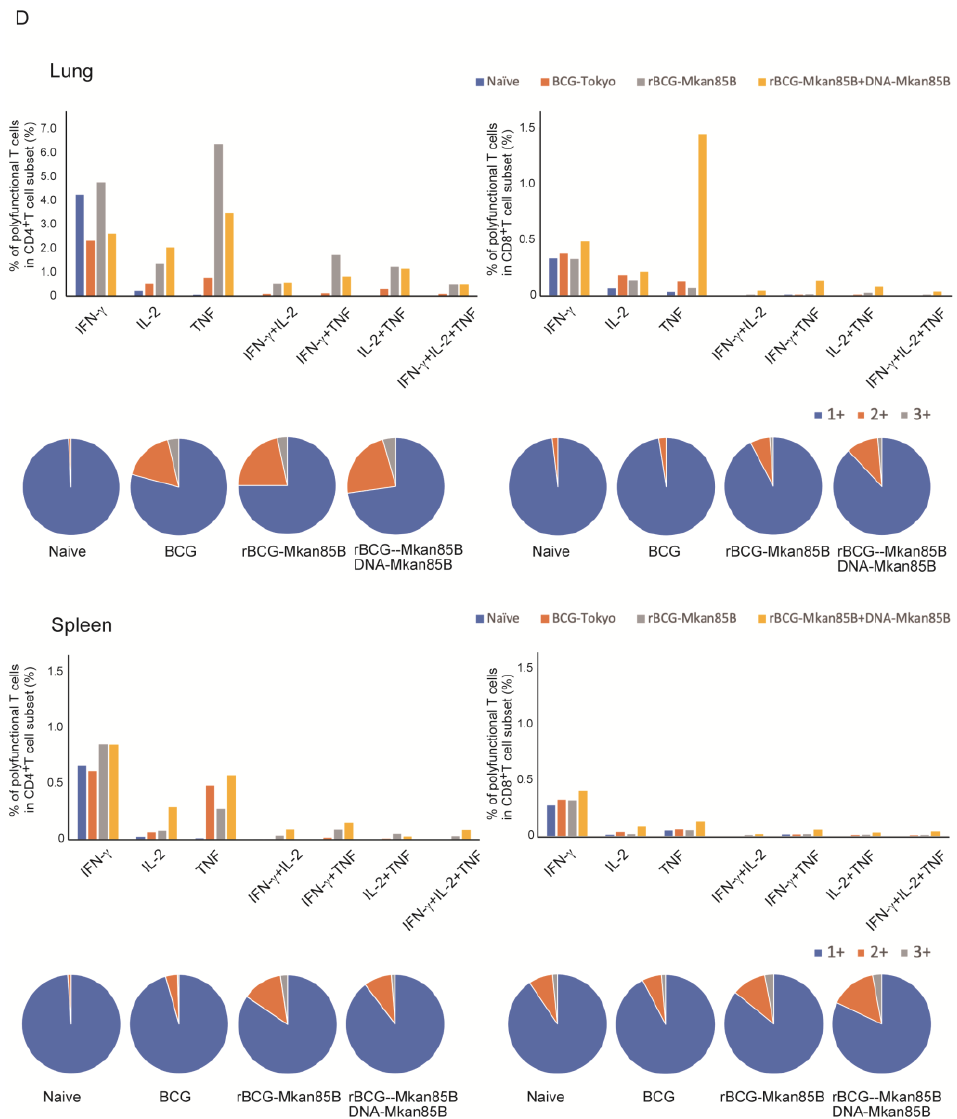
Figure 3. Polyfunctional CD4 + and CD8 + T cells in ( A ) immune cells isolated from lung ( B ) splenocytes of BCG-, rBCG-Mkan85B-, or rBCG-Mkan85B/DNA-Mkan85B-vaccinated CB6F1 mice. The induction of polyfunctional CD4 + T cells by stimulation with peptide 25 (left panel) and the induction of polyfunctional CD8 + T cells by stimulation with Pep8 (right panel) are shown. The data represent the results from three independent experiments with two to four mice per group. * p < 0.05. ** p < 0.01. ( C ) The gating strategy used to identify IFN-g-, IL-2- and TNF-producing CD4 + and CD8 + T cells among immune cells isolated from lung and splenocytes from a representative mouse is shown. The upper 4 panels show the initial gating of total events, including a singlet cell gate, followed by selection for lymphocytes. Live CD3 + T cells were identified by negative LIVE/DEAD staining and CD3 expression. CD4 + and CD8 + T cells were further identified by CD4 or CD8 expression. Antigen-specific IFN-g-, IL-2- and TNF-producing CD4 + and CD8 + T cells were gated as shown. The cells producing three, any two and only one cytokine were determined by Boolean combinations. Each cytokine-positive cell was assigned to one of seven possible combinations of these three cytokines ( D ), and the total number of cytokine-producing cells was calculated as the percent of CD4- and CD8-positive cells. The sum of the three- and two-cytokine-producing cells was measured as polyfunctional T cells specific for epitope peptides ( D ).